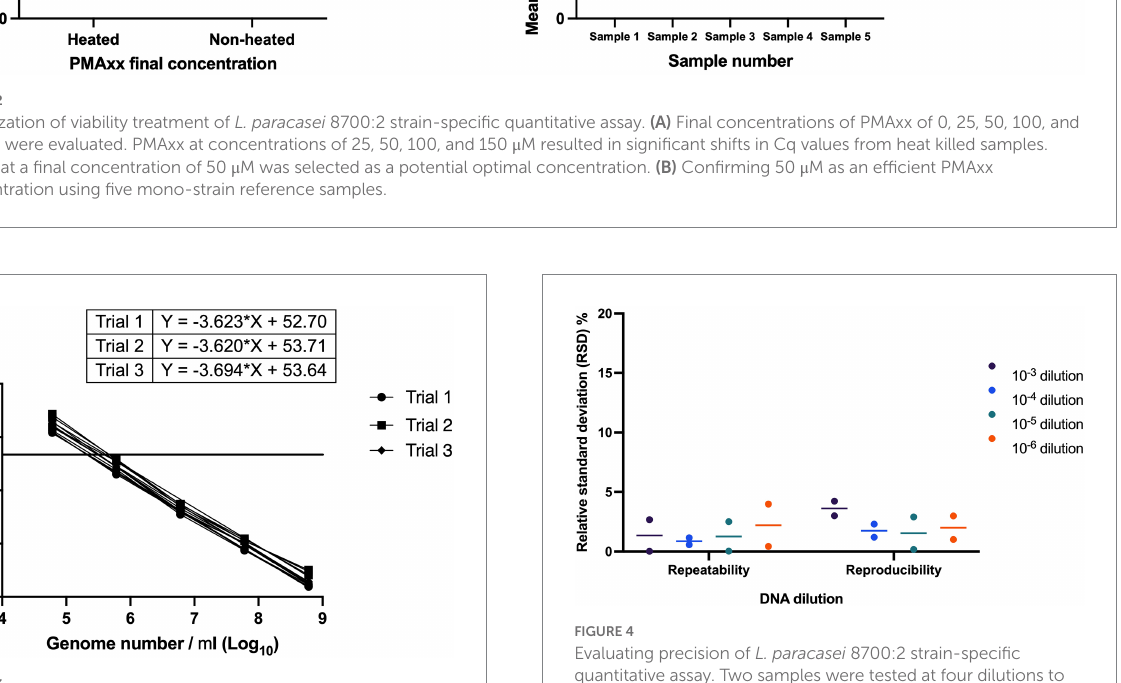
FIGURE 3 Determination of linear dynamic range, and reaction efficiency of L. paracasei 8700:2 strain-specific quantitative assay. Three independent serial dilution series were prepared from L. paracasei 8700:2 reference samples. The linear dynamic range was established between 6*10 2 to 6*10 5 genomes. Reaction efficiency was 91.5, 93.7, and 90.9%. A vertical line at a Cq value of 33 cycles refers to reaction cut-off.